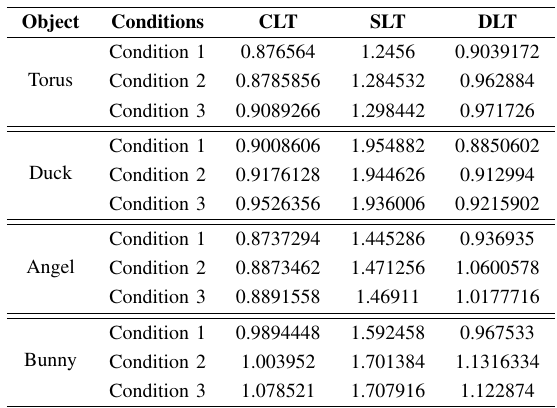
TABLE II R E - PROJECTION ERROR AVERAGE ( MM